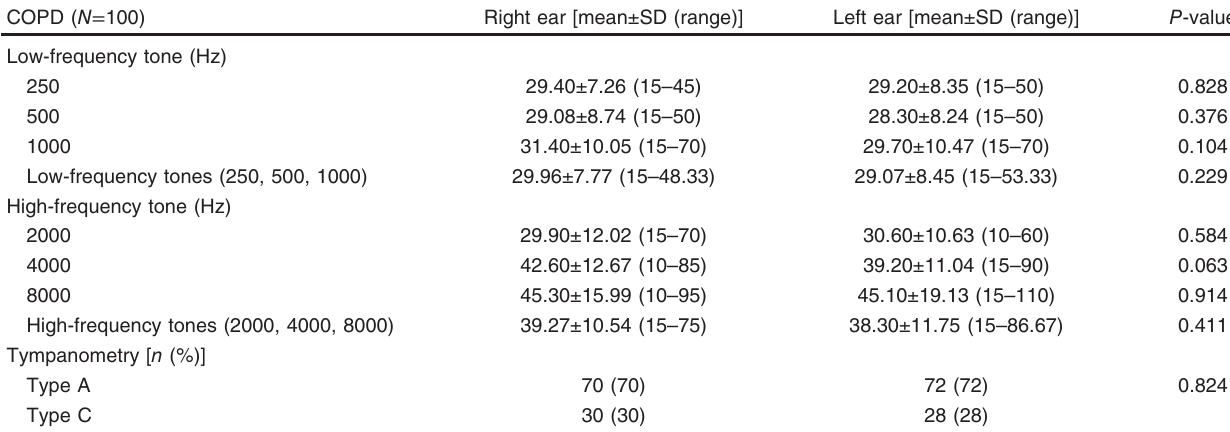
Table 2 Comparison between right and left audiometry and tympanometry in chronic obstructive pulmonary disease patients COPD ( N = 100)